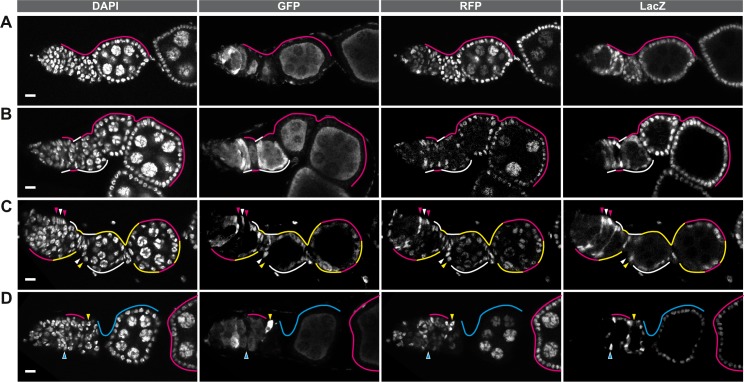
Individual channels of the four-color images.(A–D) Each of the four channels of the images in Figure 1 shown separately in monochrome. Panels A-C in Figure 1 correspond to panels A-C and panel F in Figure 1 corresponds to panel D. White lines and arrowheads indicate LacZ+ GFP+ RFP+, yellow lines and arrowheads indicate LacZ– GFP+ RFP+, magenta lines and arrowheads indicate LacZ+ GFP– RFP+, and cyan lines and arrowheads indicate LacZ+ GFP– RFP–. Scale bar represents 10 μm.